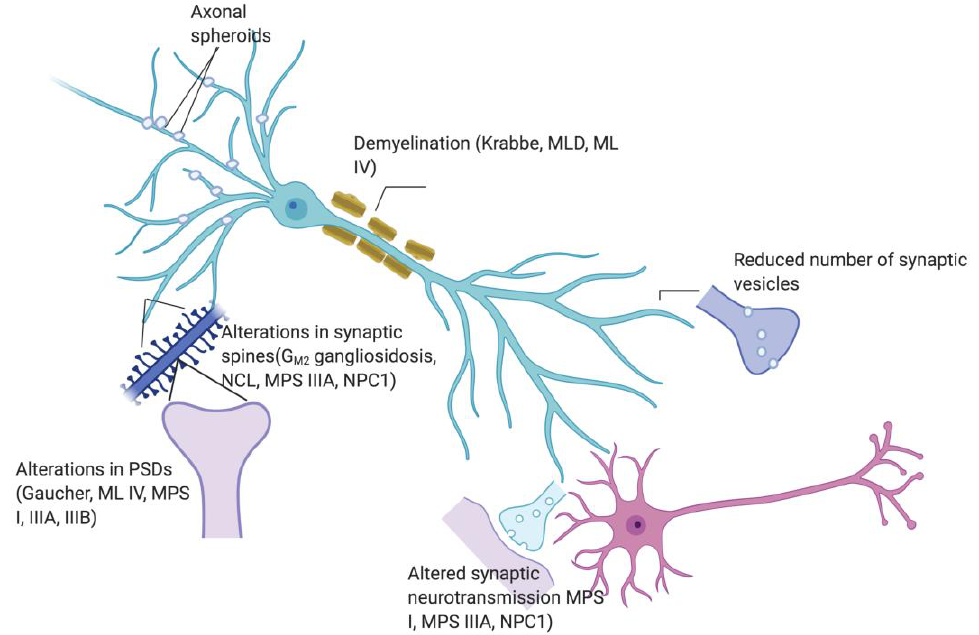
Figure 1. Scheme showing synaptic abnormalities (presence of axonal spheroids, demyelination, reduced synaptic vesicles, altered synaptic neurotransmission, altered spine morphology and alterations in post synaptic densities) in respective relevant LSD.